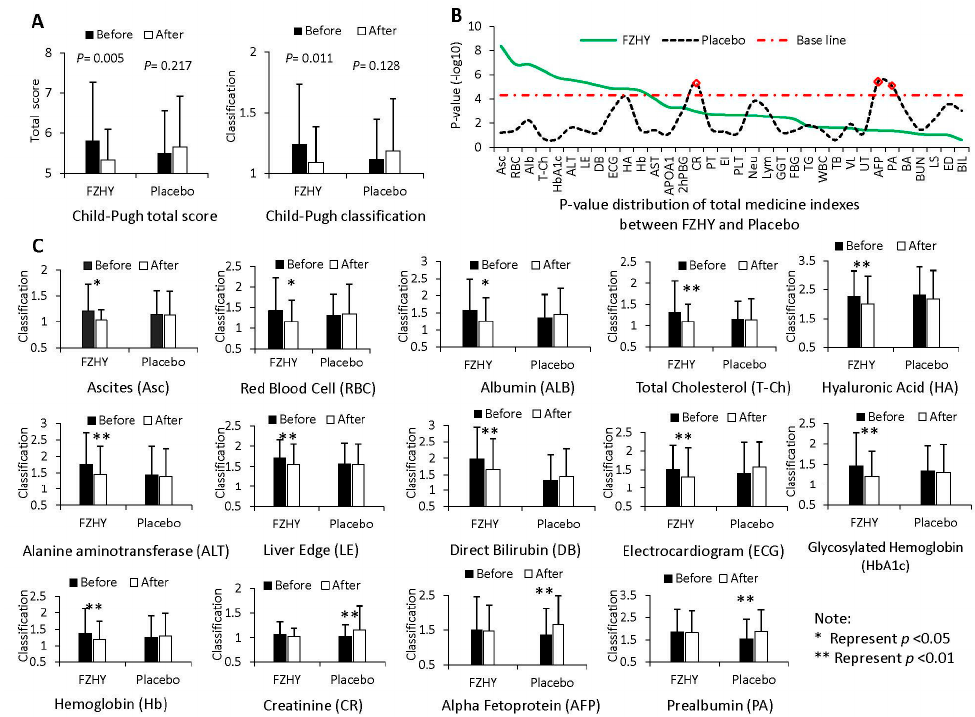
Figure 1. The clinical data analysis results between before and after treatment of Fuzheng-Huayu (FZHY) and placebo groups. ( A ) The Child–Pugh total score and classification comparison between FZHY and placebo groups; ( B ) the p -values’ distribution of medical indexes, which were tested using the random variance model of R package; ( C ) the expression levels of 14 significant medical indexes between FZHY and the placebo groups. To draw the figures conveniently, the detected value of each medical index was assigned a code (Arabic numerals); for example, 1 represents that the detected value is the normal level; 2 represents that the value is the abnormal level, but not worse; and 3 represents that the detected value is the abnormal level and worse.